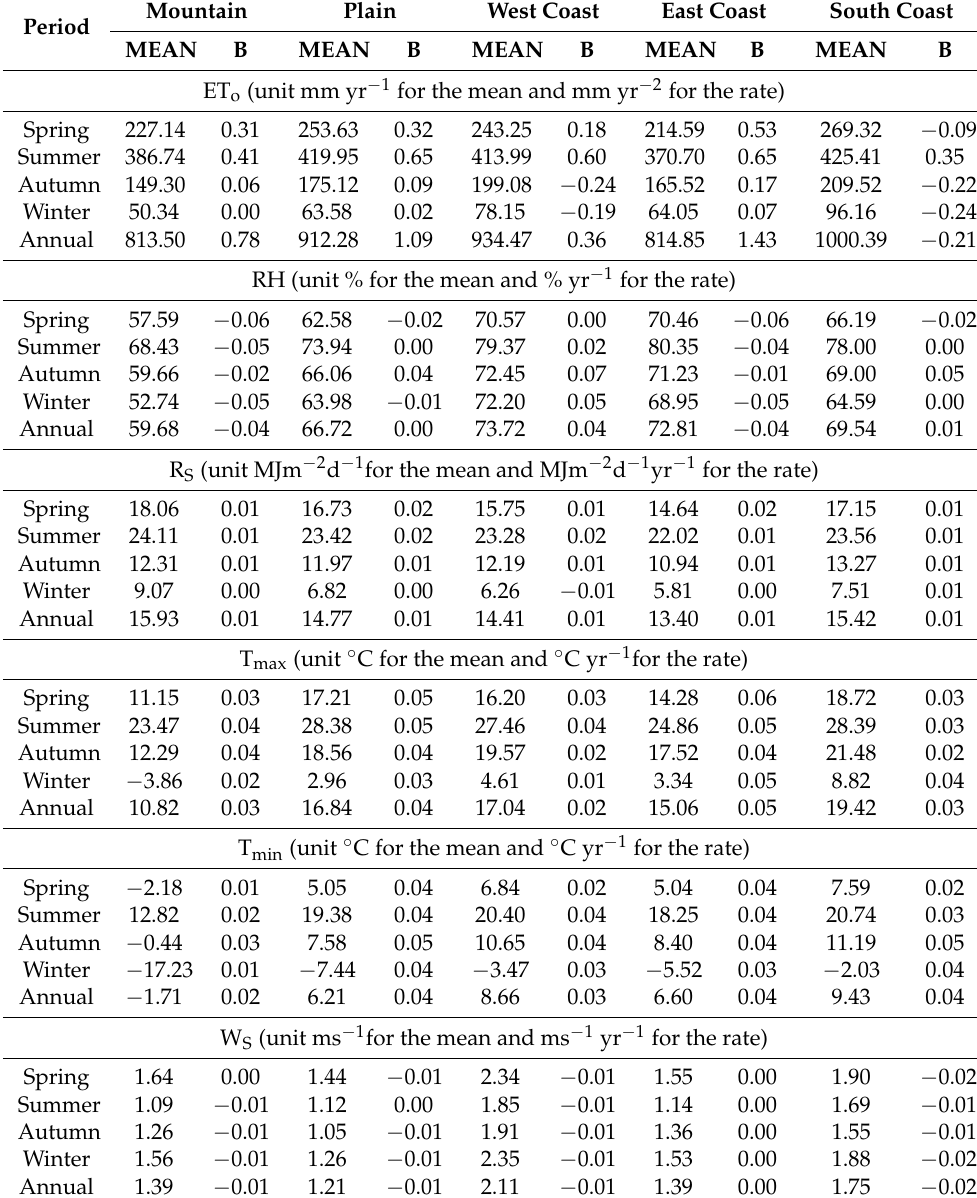
Table 4. The seasonal and annual variation of ET o and meteorological variables from 1980 to 2021 in different geographic